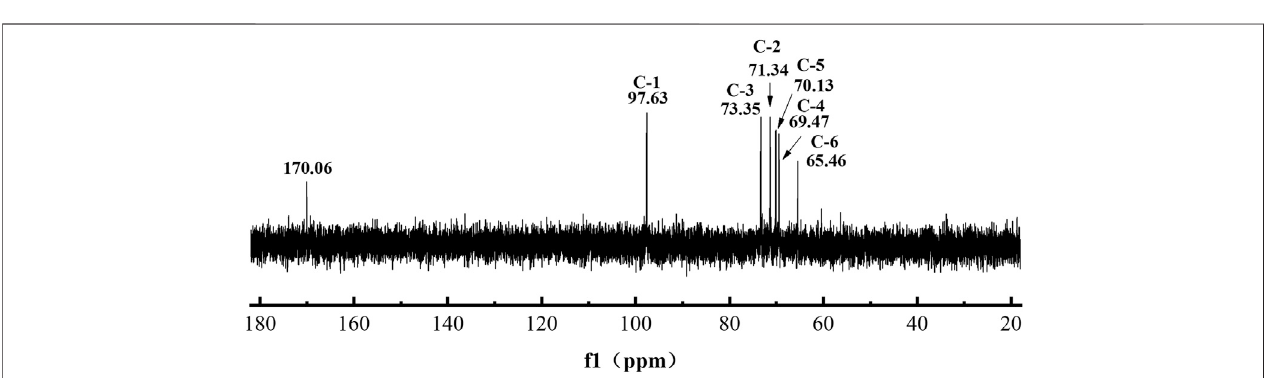
FIGURE 6 | 13C NMR spectra of NaOH-modi fi ed L-dextran synthesized by mutant Q634A